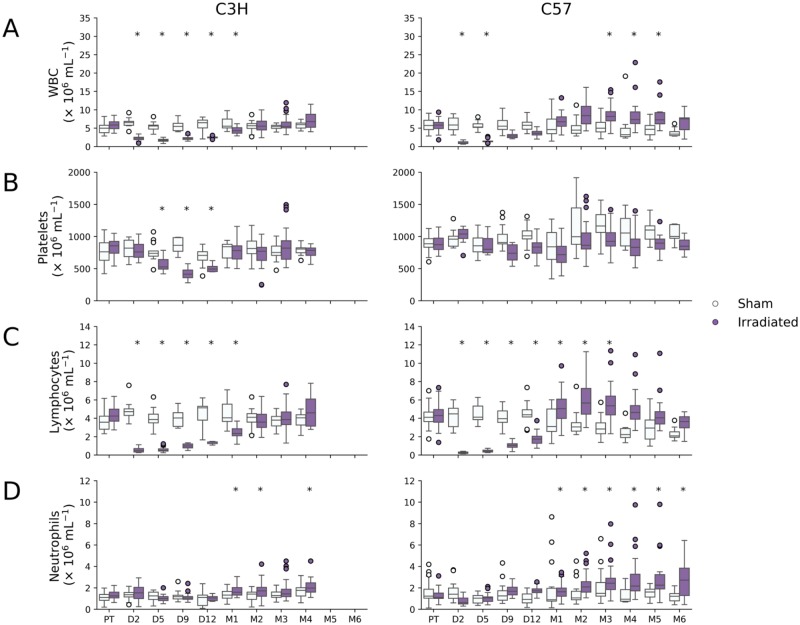
Blood cell counts for WTLI and sham irradiated C3H and C57 mice.WTLI resulted in a rapid drop in (A) white blood cells (WBC) and (C) lymphocytes in both strains of mice that recovered by month 2 in C3H mice and became slightly elevated by month 1 in C57 mice. (B) Platelets were slightly reduced in C3H mice between days 5 and 12. (D) Neutrophil counts were elevated in both strains by month 1, but more persistently in C57Bl/6 mice. Statistically significant changes in counts compared to pre-radiation levels (Dunnett’s test p-value < 0.001) are indicated by an asterisk.